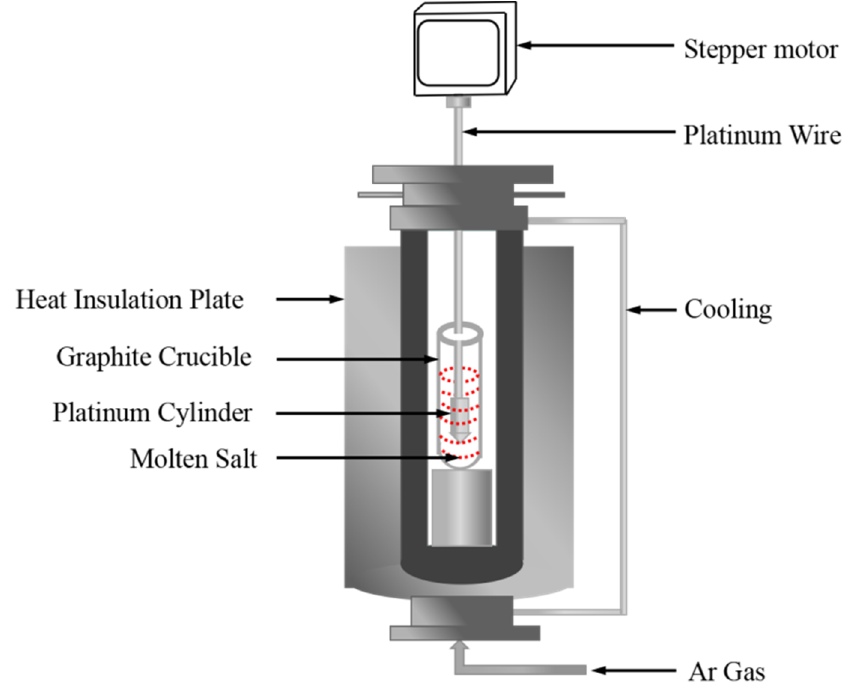
Figure 5. Schematic of the viscosity measurement method and experimental set-up.